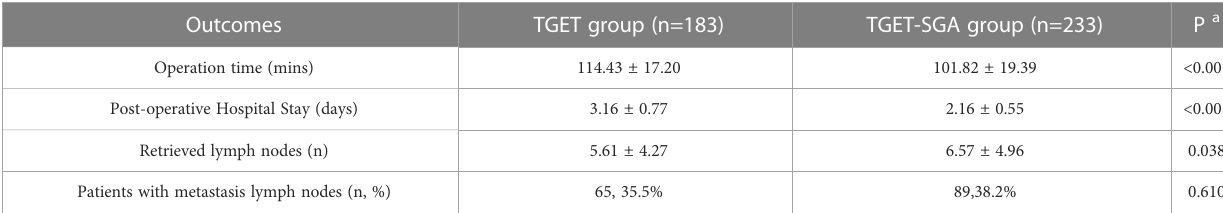
TABLE 2 The operative and pathological outcomes of TGET and TGET-SGA group.